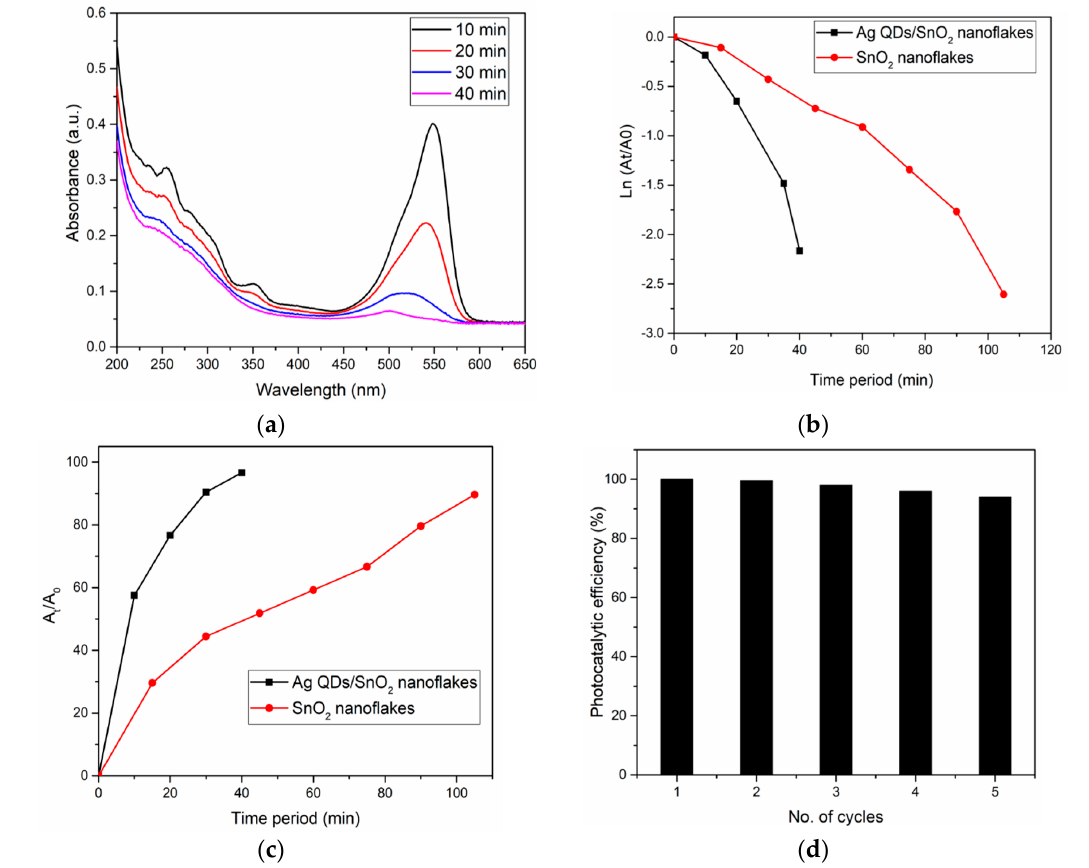
Figure 9. ( a ) Photocatalytic dye (RhB) degradation by the Ag QDs/SnO 2 nanostructures. ( b ) Photocatalytic activity comparison of the Ag QDs/SnO 2 and SnO 2 nanostructures. ( c ) Reduction of RhB at specific time intervals with various catalysts. ( d ) Ag QDs/SnO 2 nanoflake stability: photocatalyst recycling under light illumination.